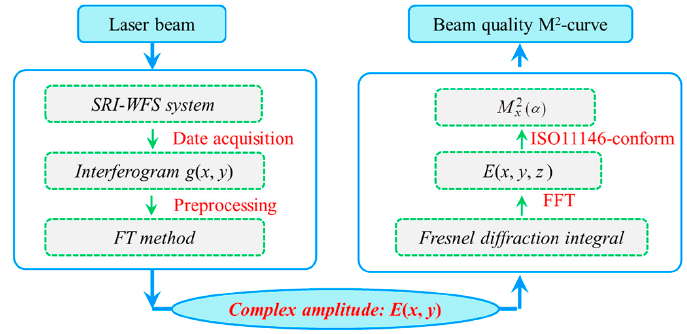
Figure 3. The flow chart of beam quality M 2 -curve determined by the proposed SRI-WFS method.